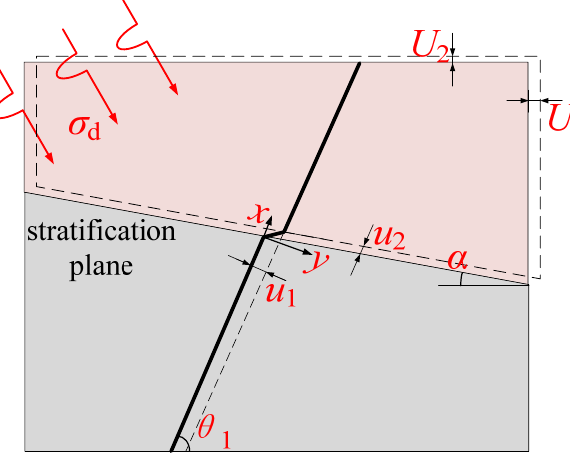
Figure 4. Instantaneous shear model of anchor solid bedding plane.